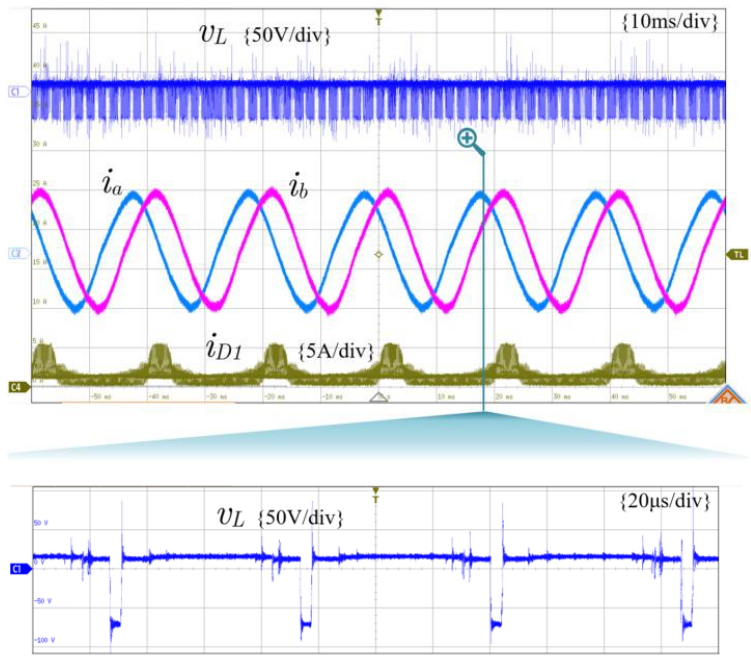
Figure 23. Five-phase SSI prototype.